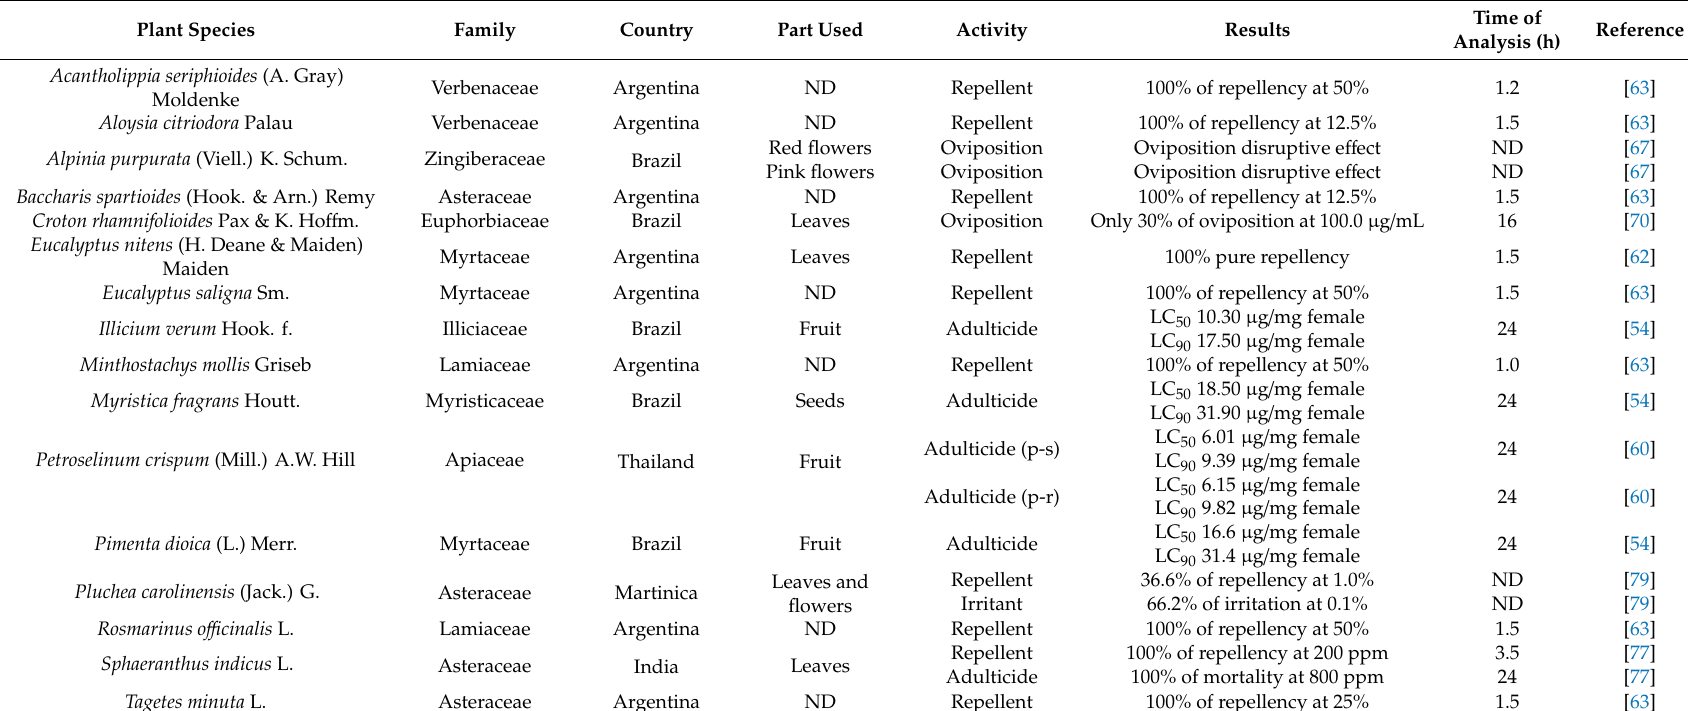
Table 2. Adulticidal, repellent and oviposition activities of essential oils against the Ae. aegypti mosquito. Plant